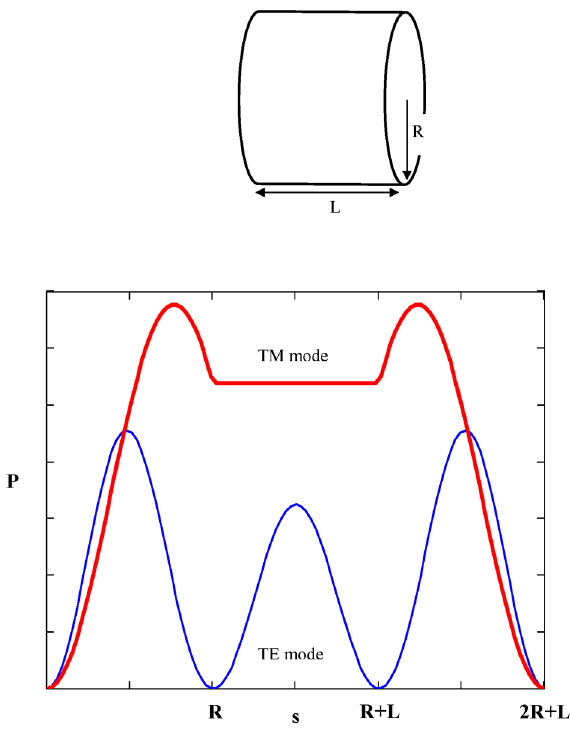
FIG. 1. (Color) Power deposition into the surface of a pillbox and the TE mode along the cavity cavity for the TM 010 011 surface. The plot starts at the center of an end wall, moves out radially, and then proceeds